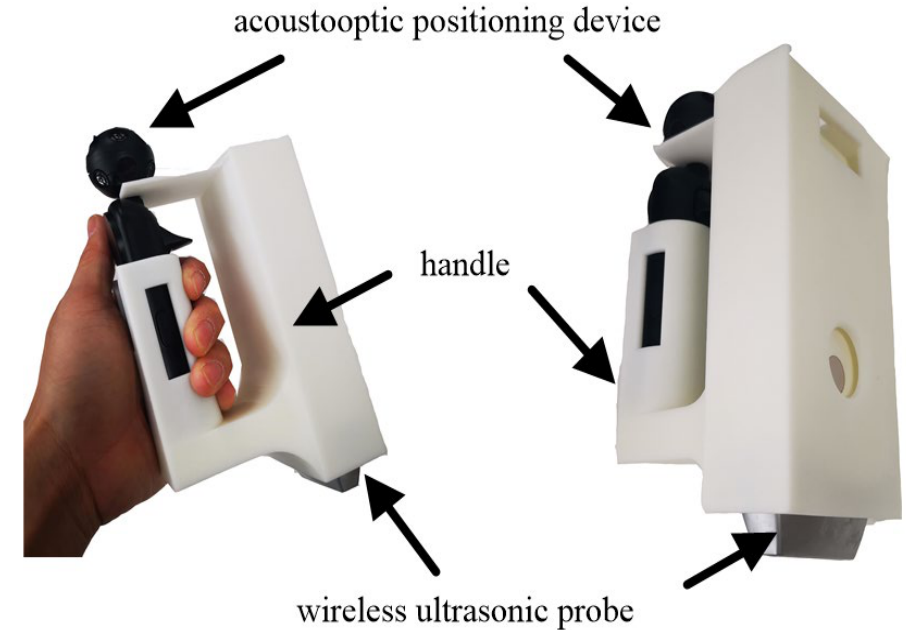
Figure 9. Data acquisition handle with positioning device.